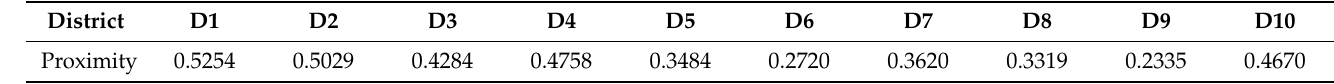
Table 6. The proximity of each district.